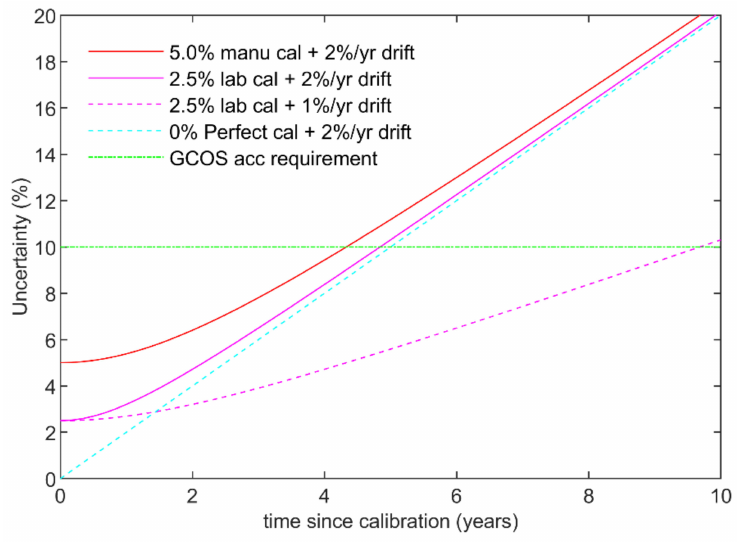
Figure 9. Sensor uncertainty over time for a range of radiometic calibration accruacies and drift term magnitudes. All uncertainties are assumed to be k = 1, please refer to Equation